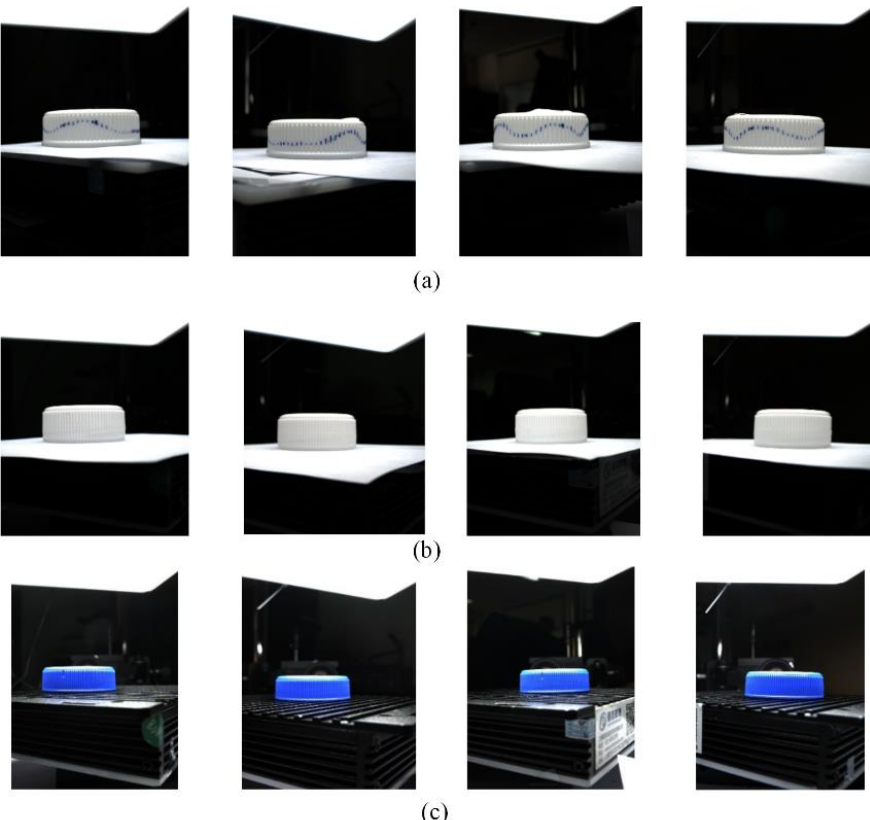
Figure 12. ( a ) Sample 1; ( b ) Sample 2; ( c ) Sample 3.